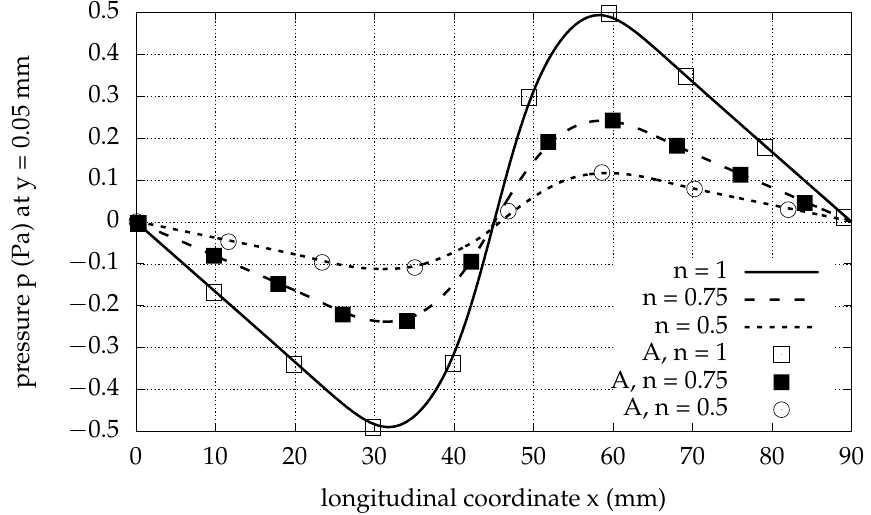
Figure 8. Pressure near the central axis of the pump ( y = 0.05 mm) for Newtonian and non- Newtonian fluids, c = 5 mm/s, RO = 0.6 and one roller. Comparison with existing results (A: Data from [12]) is